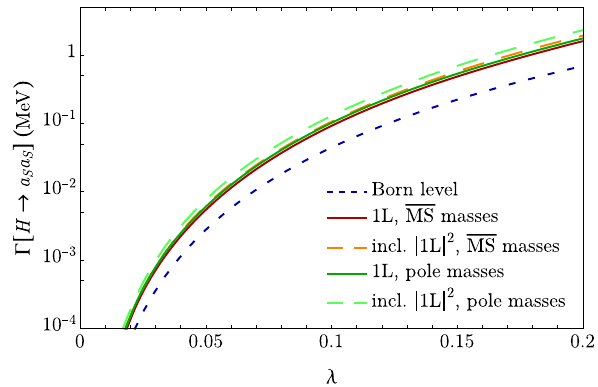
Fig. 5 SU ( 2 ) L -violating two-body decay width (cid:6) [ H → a S a S ] in an ! = λ = 300GeV NMSSM scenario with κ , M H ± = 3TeV and M a S (and h S kinematically inaccessible). The convention for the curves is the same as in Sect.